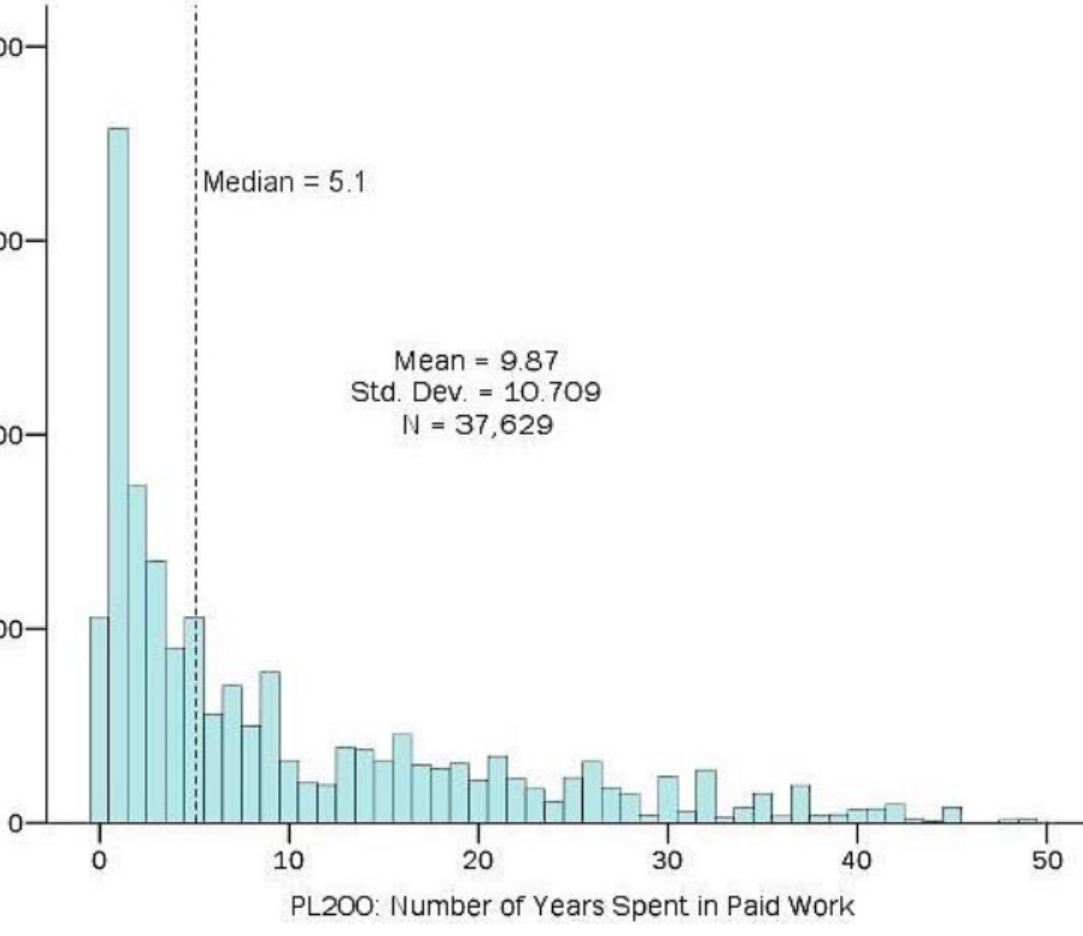
Figure 8. Distribution of precarious workers by professional experience. Data source: Eurostat EU-SILC (2020).